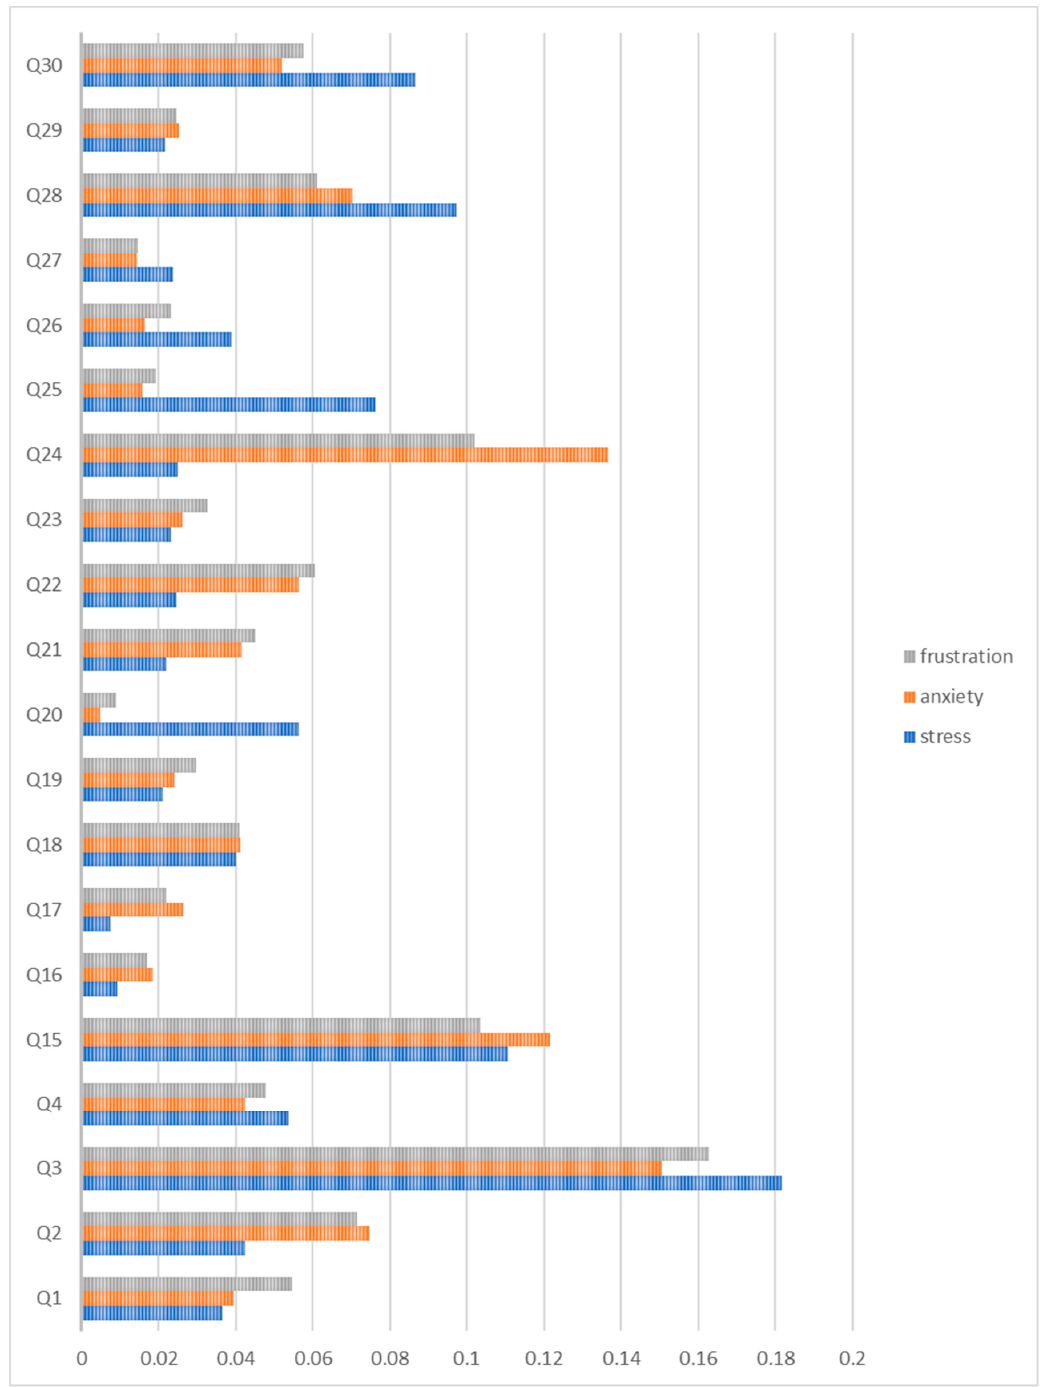
Figure 2. Relative importance summary of the RF model for overall stress, anxiety, and frustration throughout the consultation